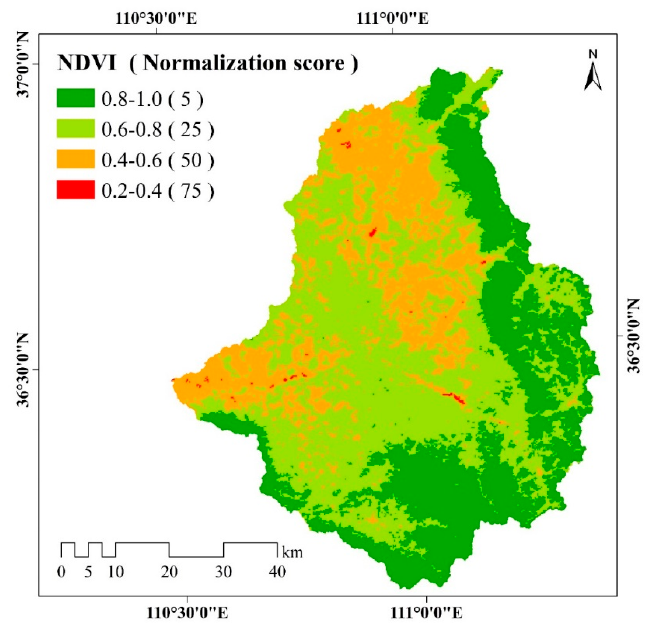
Figure 9. Spatial distribution of NDVI in the study area. NDVI is divided into 4 classes, 0.2–0.4, 0.4–0.6, 0.6–0.8 and 0.8–1.0. Different color represent different NDVI class. Higher normalization score of NDVI represent a greater impact on soil erosion.